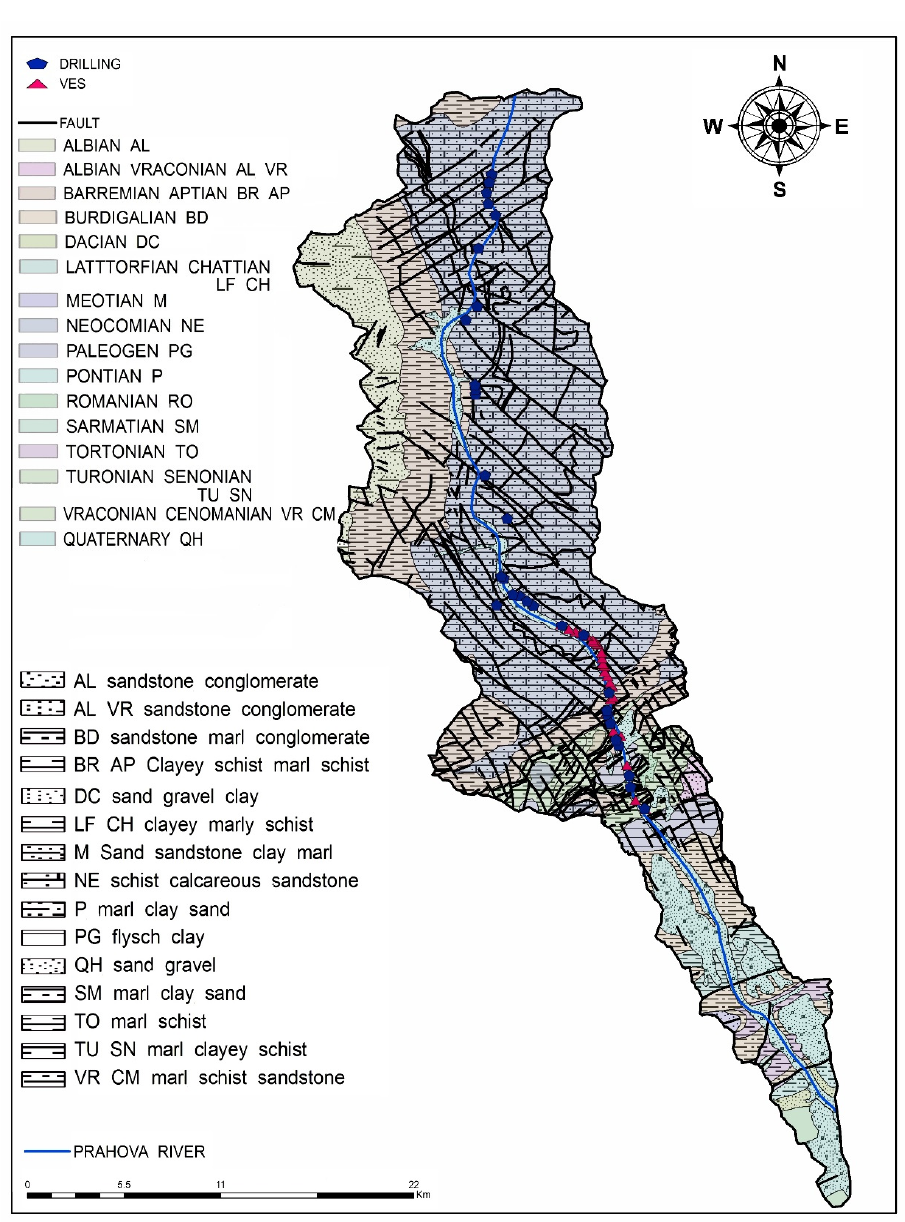
Figure 2. Geological and lithological settings. We used the color codes in the geological